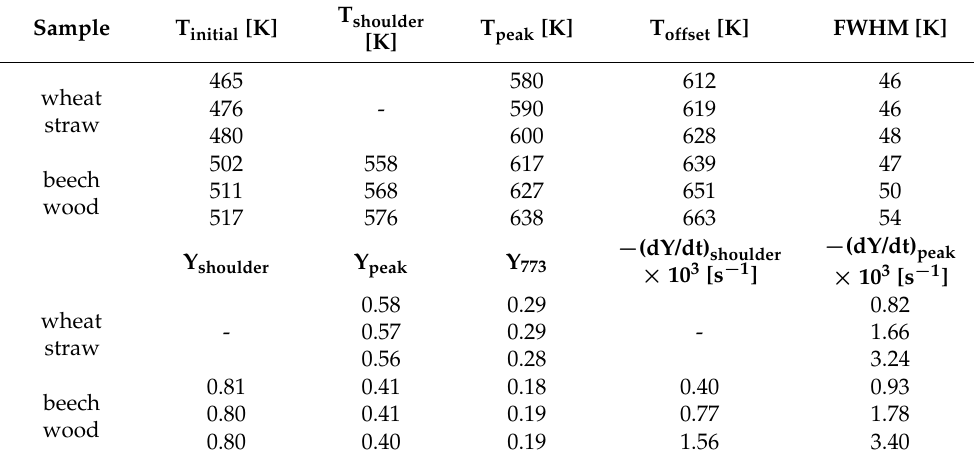
Table 1. Characteristic parameters of the thermogravimetric curves for wheat straw and beech wood [22]: initial degradation temperature, T initial , temperatures T peak and T offset at the peak and tail of the mass release rate curve, FWHM, the temperature range corresponding to the full width of the rate curve at half maximum, mass fractions, Y peak , and rates of mass loss, ( − dY/dt) peak , in correspondence to the peak rate and mass fraction at a temperature of 773 K (char yield), Y 773 .